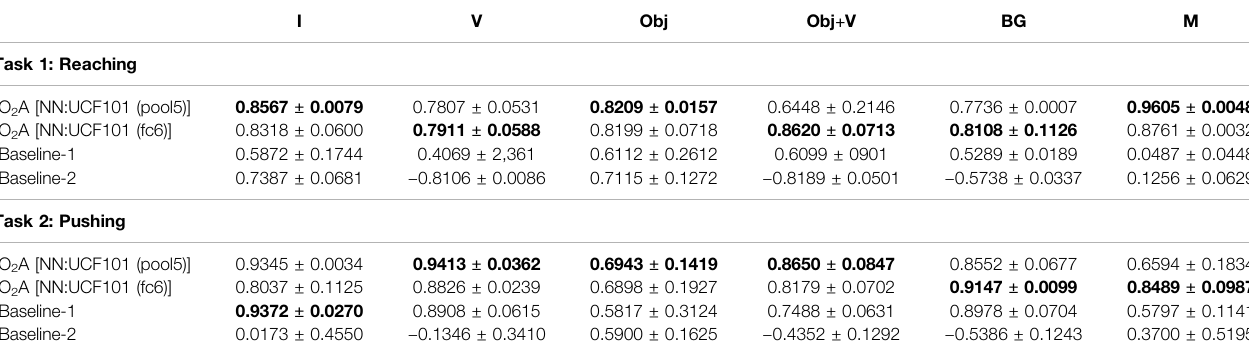
TABLE6| Pearsoncorrelationcoef fi cientsbetweentherewardsfromtheOracle,andfromO2Aandtwobaselines.Thecoef fi cientsaregenerallyhighestandpositiveforO 2 A rewards compared to baseline